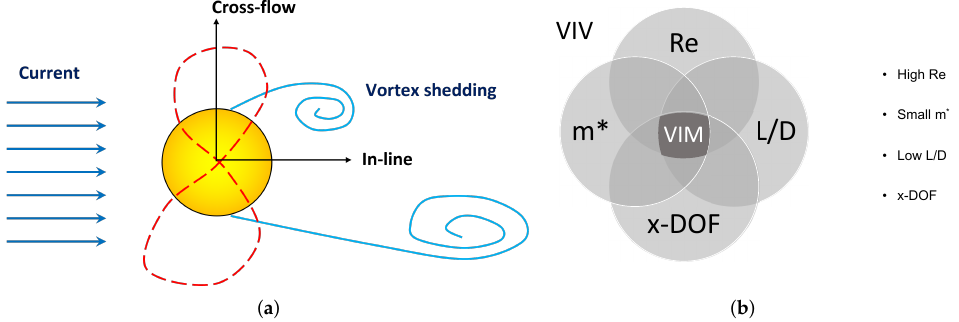
Figure 3. VIV and VIM. ( a ) Sketch illustrates VIV. Fluid–structure interaction due to alternative vortex shedding. Two degree-of-freedom (DOF) motions of a cross-section. ( b ) VIM is a particular case of VIV on cylinders with low aspect ratio A R , small mass ratio ( m ∗ ), at least 2 DOF and high Reynolds numbers. Sketch inspired of Figure 2 of